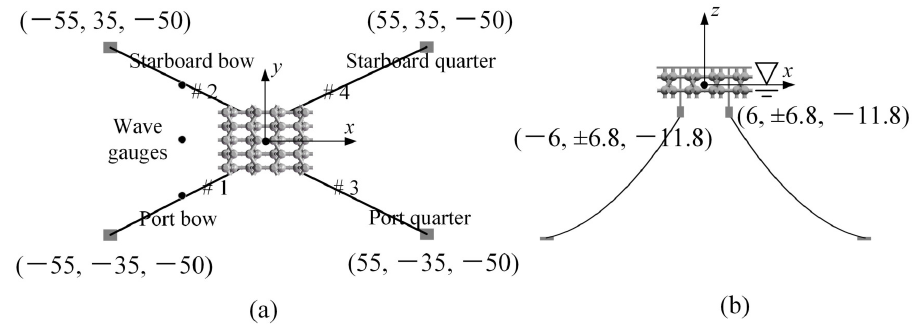
Figure 5. Mooring line configuration: ( a ) top view; ( b ) side view.